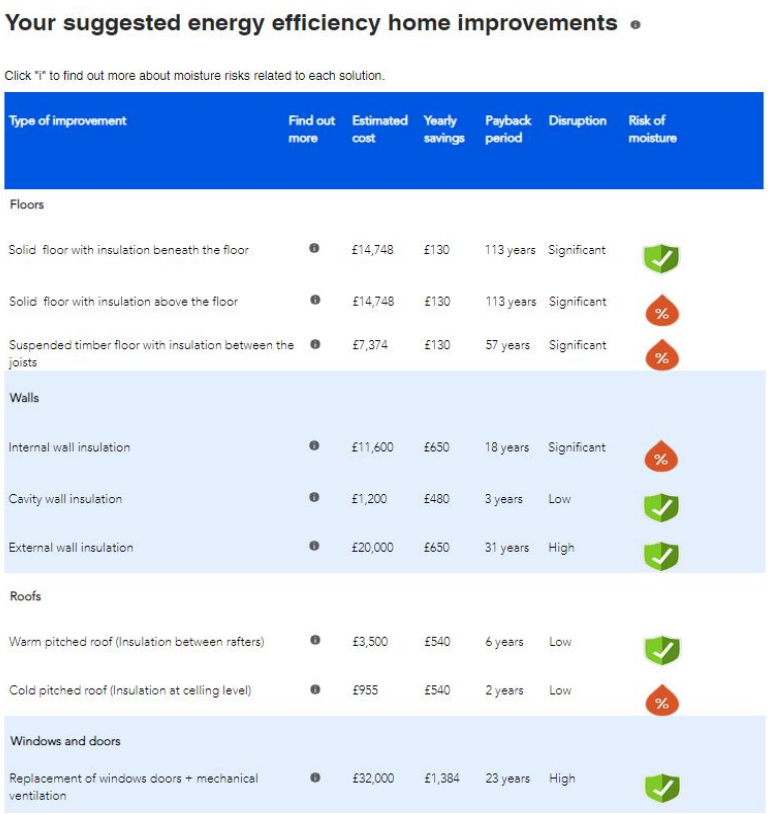
Figure 6. Existing specifications section.